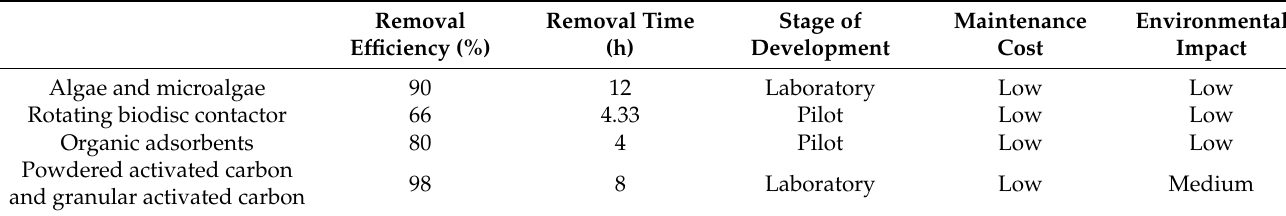
Table 2. Analysis parameters of the studied